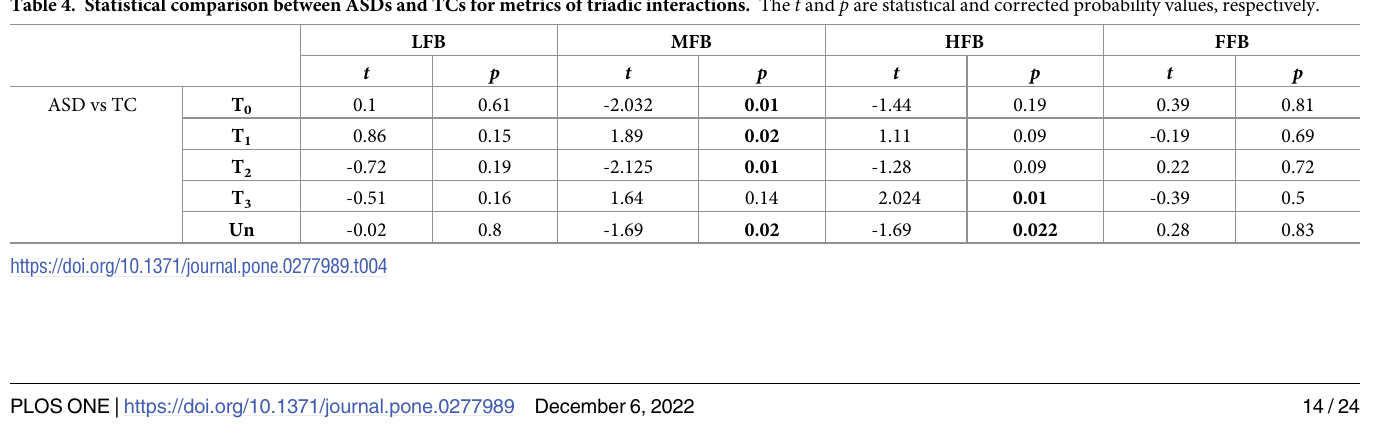
The results of the statistical comparison are listed in Table 4. The statistically significant dif- ferences between ASDs and TCs were only seen in the MFB and HFB. The results of GFBs are shown in Fig 4. The Log-Log distribution of Un at LFB, MFB, and HFB are plotted in S3 Fig in S1 File. For both groups, by moving from LFB to higher graph frequencies, significant high-level changes were seen for |T |, |T |, and |T |. The greatest changes were for |T | and |T |. The ear- 0 1 3 0 3 lier one increased by a factor of 5–6, and the latter decreased by a factor of 3. The |T | increased 1 by a factor of close to 2. The significance between-groups differences were found in the MFB (for |T |, |T |, and |T |) and HFB (for |T |). The number of unbalanced triads T and T were 0 1 2 3 0 2 significantly lower for ASDs compared to TCs in the MFB ( t = -2 . 03 , p = 0 . 01 for T ; t = -2 . 12 , 0 p = 0 . 01 for T 2 ). In contrast, the |T 1 | and |T 3 | were significantly higher for ASDs compared to TCs in the MFB ( t = 1 . 89 , p = 0 . 02 ) and HFB ( t = 2 . 02 , p = 0 . 01 ), respectively. The general pat- tern in the MFB and HFB was a higher/lower number of balanced/unbalanced triads for ASDs compared to TCs. The energies (Un) of the two groups were negative and approximately equal in the LFB. For TCs, the energies in the MFB and HFB were more than the energy in the LFB. In contrast, increasing the graph frequencies was accompanied by decreasing the energy level for ASDs. Consequently, significant differences were seen between energies of ASD and TC groups in the MFB ( t = -1 . 69 , p = 0 . 02 ) and HFB ( t = -1 . 69 , p = 0 . 022 ).